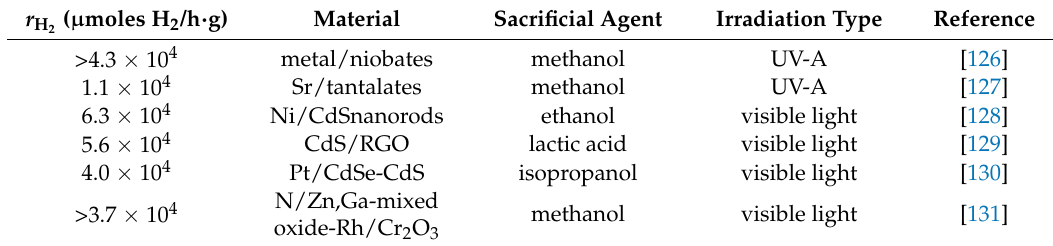
Table 2. Selected relevant hydrogen production rates recorded during photoreforming of organics over various